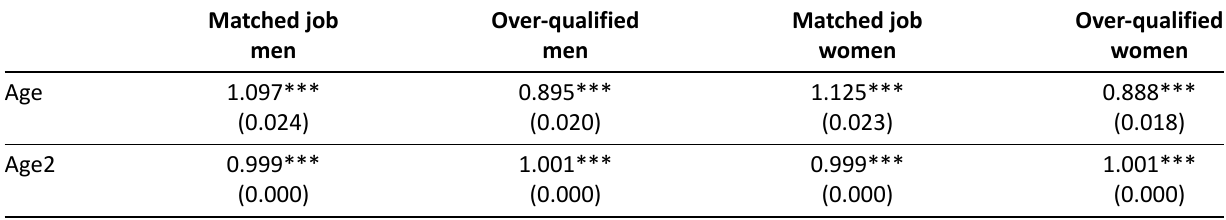
Table A7. Binary logistic regression model on matched job and over-qualification, interacting origin with sector of